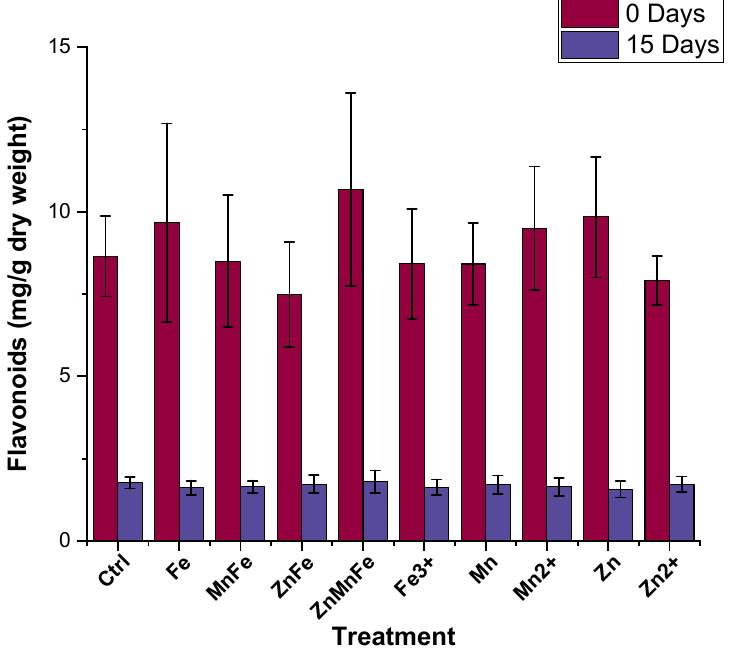
Figure 9. Flavonoid content of tomato fruits stored at room temperature for 0 and 15 days after treatment with either Fe 3 O 4 (Fe), MnFe 2 O 4 (MnFe), ZnFe 2 O 4 (ZnFe), Zn 0.5 Mn 0.5 Fe 2 O 4 (ZnMnFe), Mn 3 O 4 (Mn), ZnO (Zn), or their ionic counterparts; n = 4 .